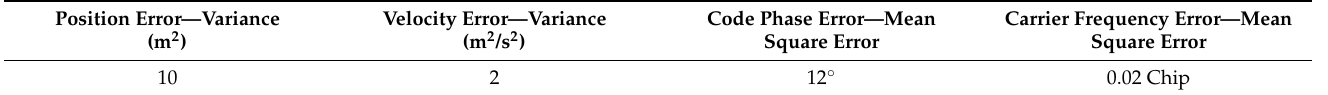
Table 1. Initial settings of the relevant data of the vector